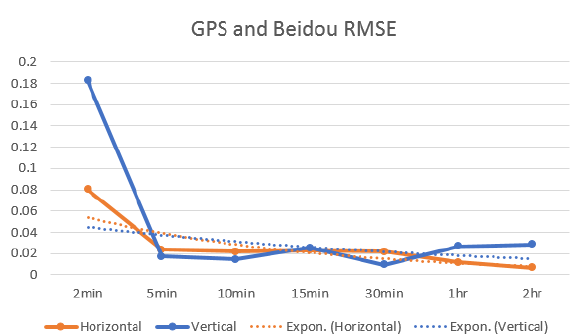
Figure 10. RMSE of horizontal and vertical observations using all GNSS signals. Y-axis in meters.